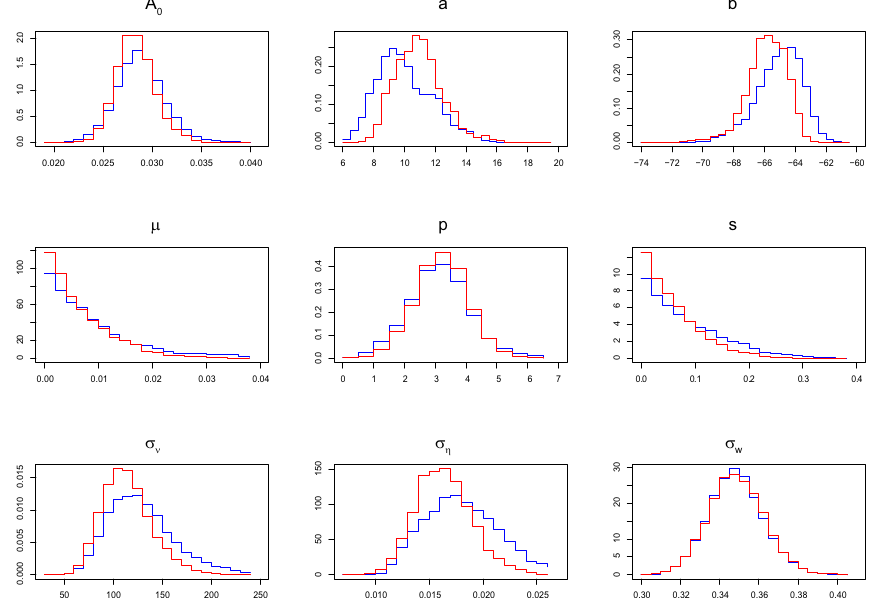
Figure 9. Estimated marginal distributions of each of the nine parameters: without using the last five tie points (blue) and with all the tie points (red).